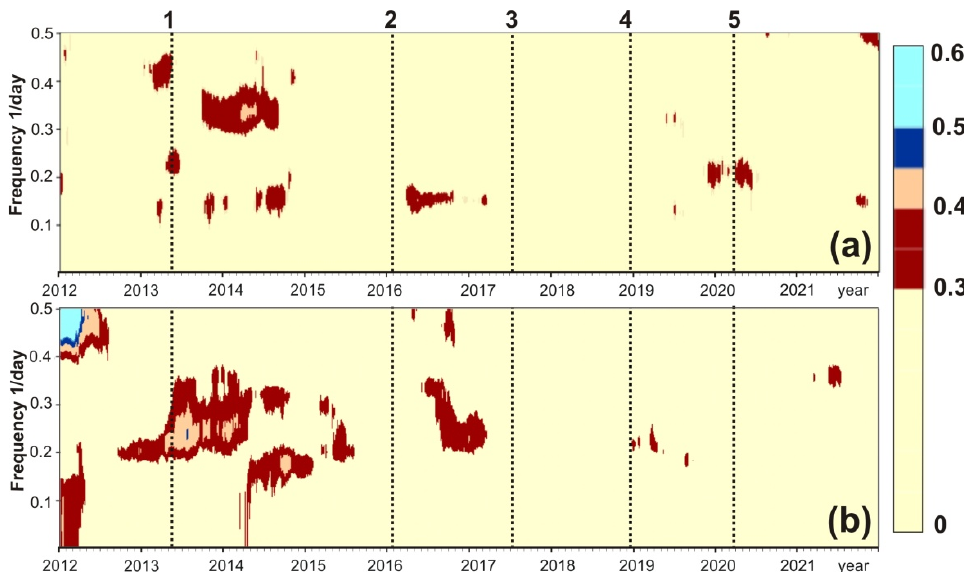
Figure 6. Time-frequency diagrams of the spectral measure of coherence of 4-dimensional time series of seismic noise parameters ν ( τ , ω ) in comparison with occurred earthquakes (Table 3) constructed from ( a ) the group of volcanic stations and ( b ) the group of coastal stations,